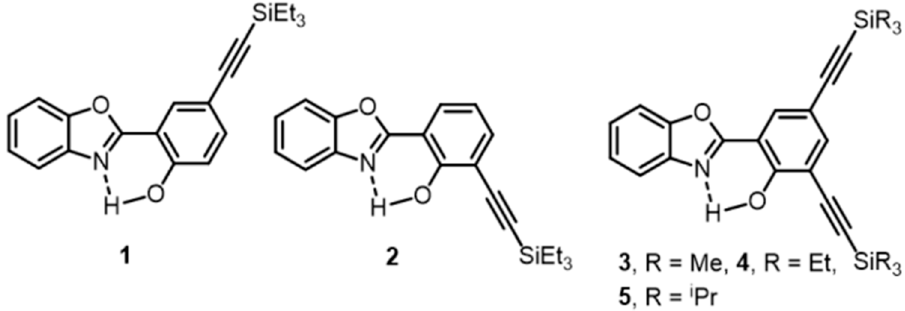
Figure 2. Molecular structures of the studied 2-(2 ′ -hydroxyphenyl) benzoxazole (HBO) fluorophores.